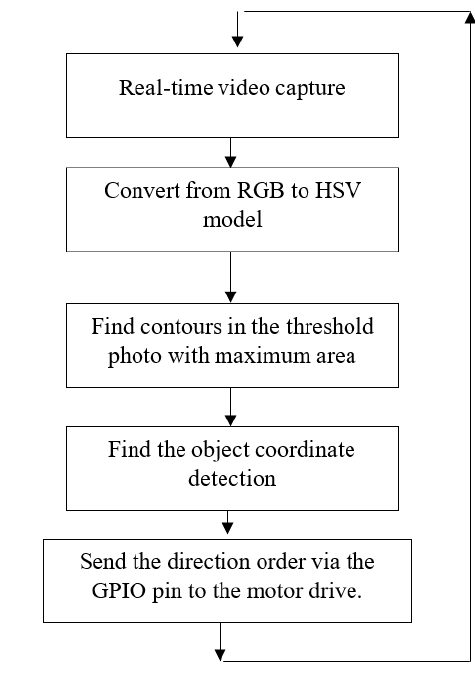
Figure 10. Flow-chart for shopper tracking by a colored jacket.